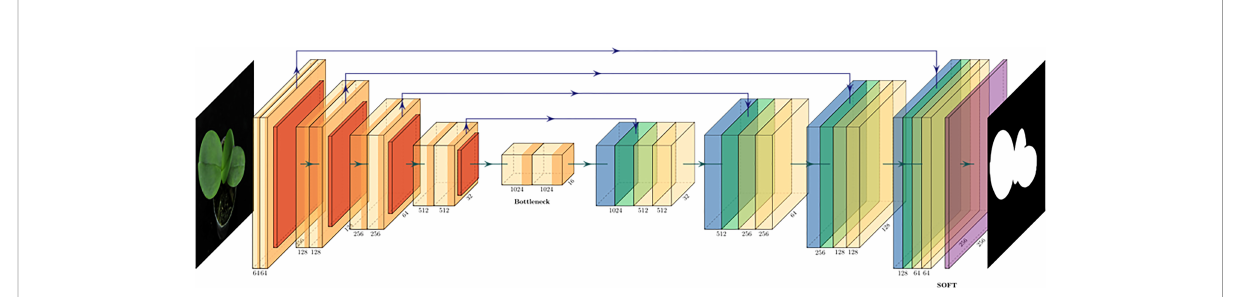
FIGURE 5 The U-net model for automatic leaf region prediction.